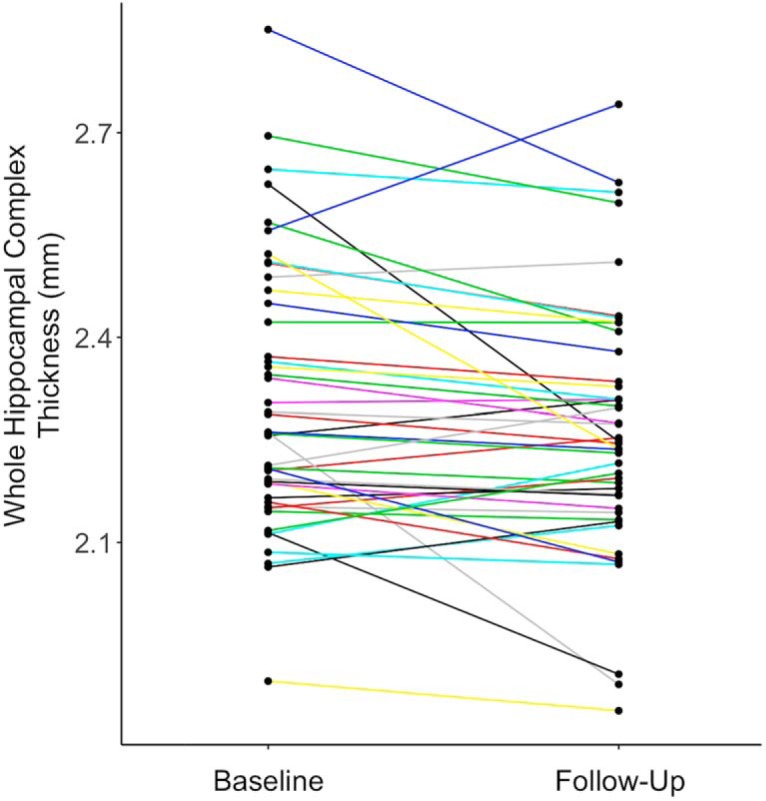
Longitudinal hippocampal complex gray matter thickness. Each participant’s mean thickness across the whole hippocampal complex is plotted at baseline and at follow-up. Most participants experienced modest changes in thickness, while fewer subjects had more dramatic changes in thickness, usually as decreases in thickness. Only one subject had an increase in mean thickness >0.15 mm.